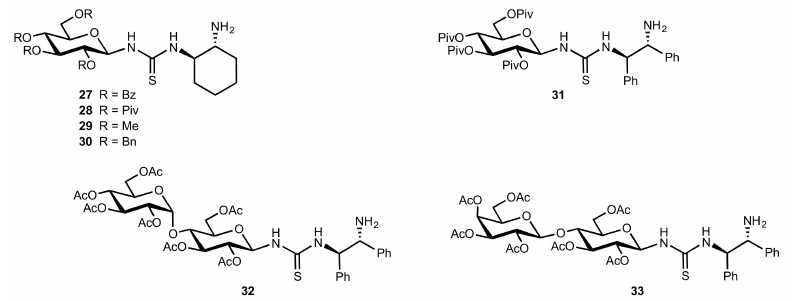
Figure 4. Bifunctional organocatalysts used in the Michael addition of ketones to nitrodienes. Only the products of 1,4 addition were observed, and they were formed in moderate to high yield (48–98%) and high enantioselectivity (84–99% ee ). The reaction was